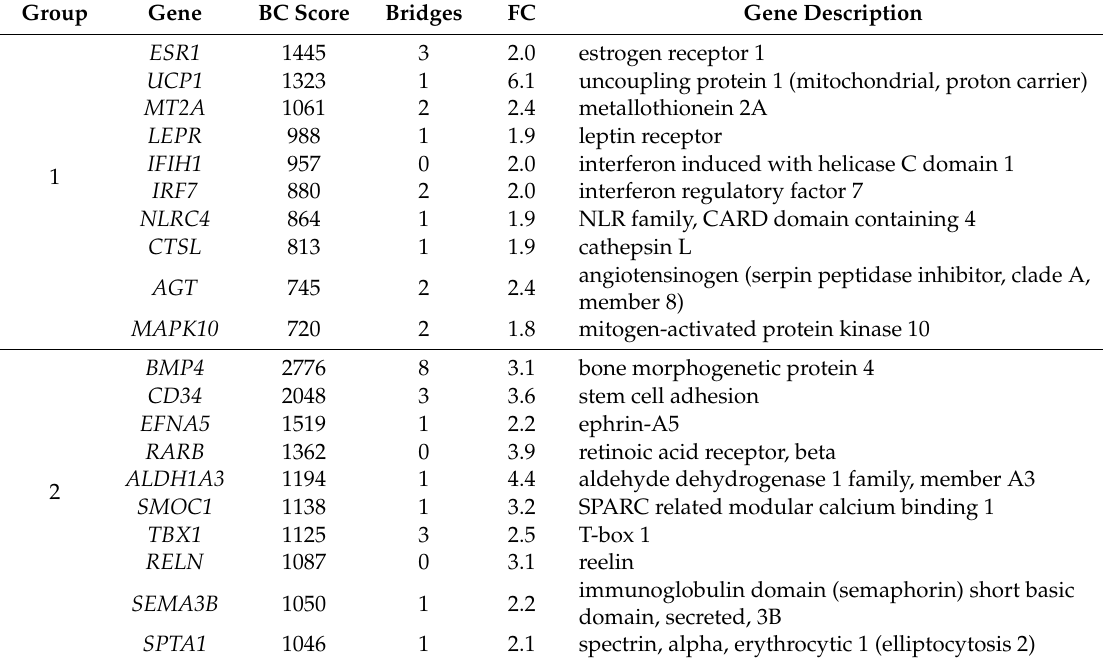
Table 1. Betweenness centrality (BC) score and Bridges number identified based on STRING Interactome network analysis by Igrapg R and Fold Changes (FC) identified by DESeq in R of the di ff erentially expressed genes DN vs. SC comparison. Average FC when two data were considered (Groups 1 and 2 respectively), n = 9